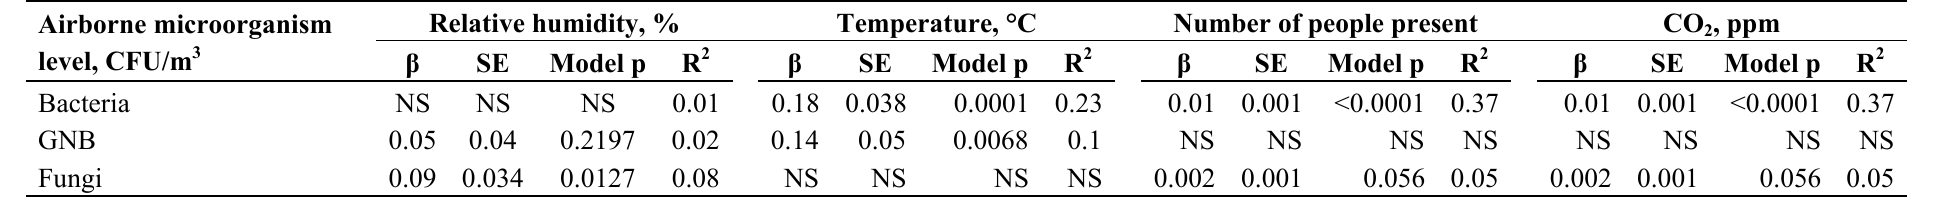
Table 4. Relationship between the levels of log-transformed airborne microorganism and quantitative variables. Airborne microorganism